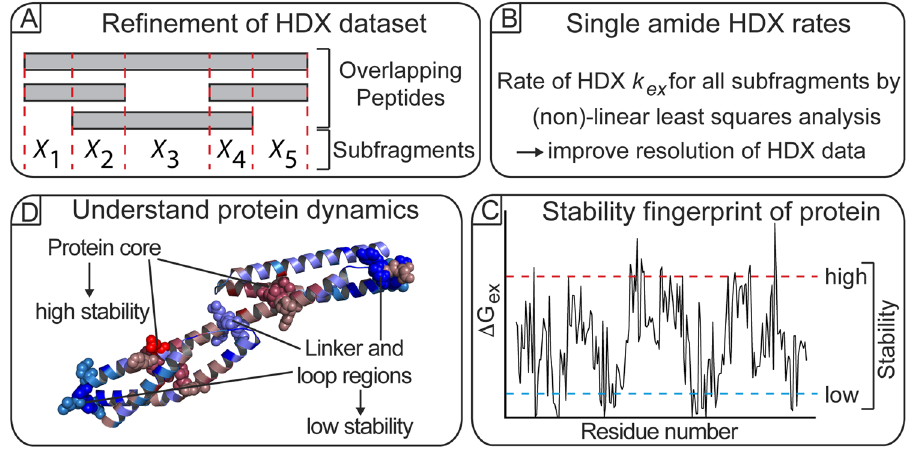
Figure 2. Workflow of HR-HDXMS. ( A ) Amino acid subfragments are determined from overlapping peptides generated by proteolytic digest of the protein. ( B ) The rate of hydrogen-deuterium exchange ( k ex ) of each subfragment is calculated by linear and non-linear least squares analysis. ( C ) The free energy value Δ G ex derived from k ex is used to generate a stability fingerprint of the protein. ( D ) The protein fingerprint helps in understanding protein dynamics and allows predictions about residues that might be essential for protein stability and/or